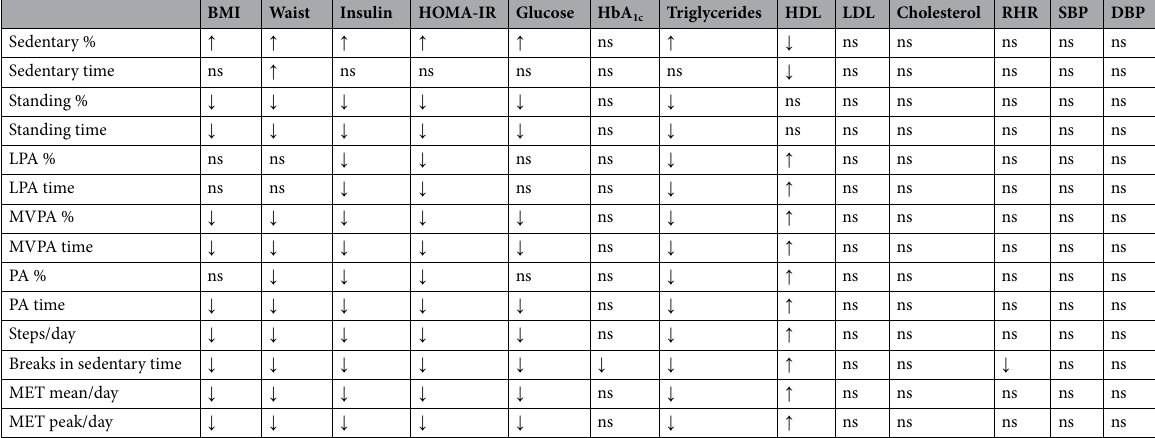
Table 7. Summary table, associations between accelerometer measures and metabolic outcomes derived from clinical investigation and fasting blood samples measured by linear models with age and sex included in the analyses . For lipid-related outcomes, the possible use of cholesterol-lowering medication (statins) was included the model; and for blood pressure-related outcomes, the possible presence of medical treatment of hypertension was included the model. BMI body mass index, HOMA-IR homeostasis model for insulin resistance, HbA1c glycated hemoglobin, HDL high density lipoprotein, LDL low density lipoprotein, RHR resting heart rate, SBP systolic blood pressure, DBP diastolic blood pressure; ns non-significant, LPA light physical activity, MVPA moderate to vigorous physical activity, PA physical activity (LPA and MVPA together), MET the metabolic equivalent. The significant positive and negative associations are indicated by upward ↑ and downward ↓ arrows,